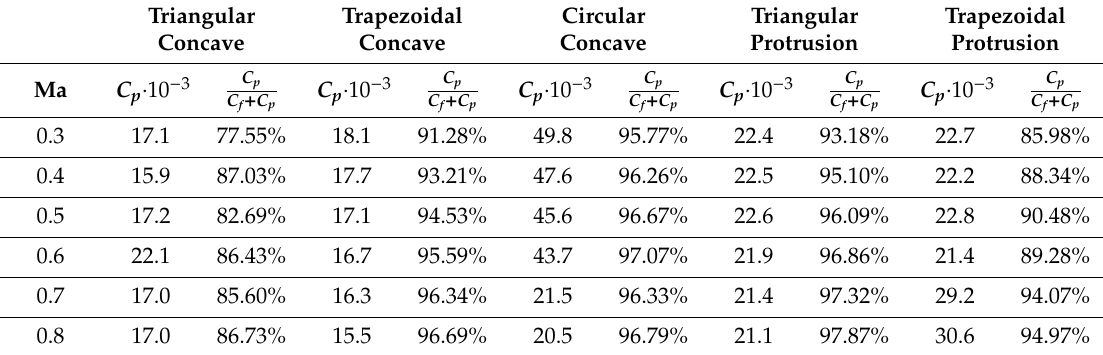
Table 4. Pressure resistance coe ffi cient with di ff erent Mach